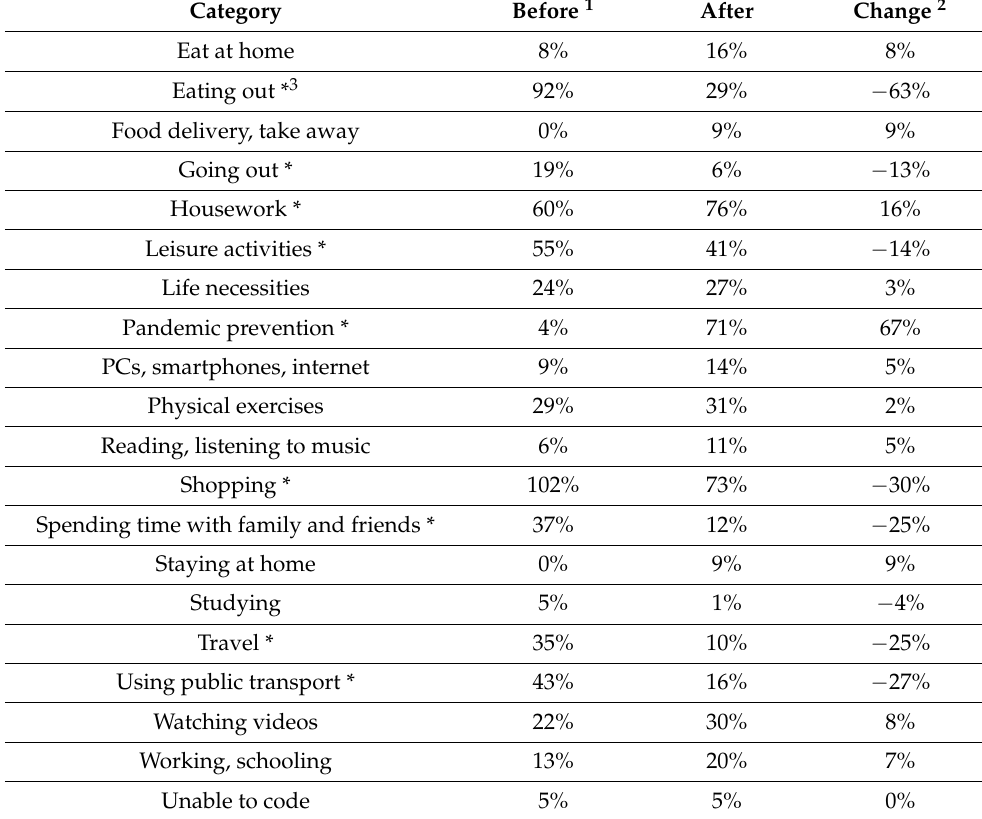
Table 2. Appearance rates for the 19 behavior categories in the ‘before’ and ‘after’